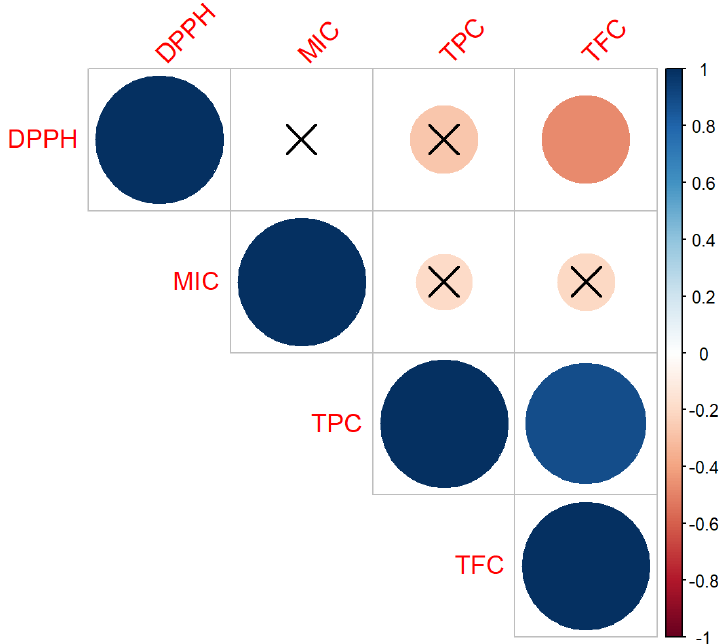
Figure 4. Correlation plot for the antioxidant activity.